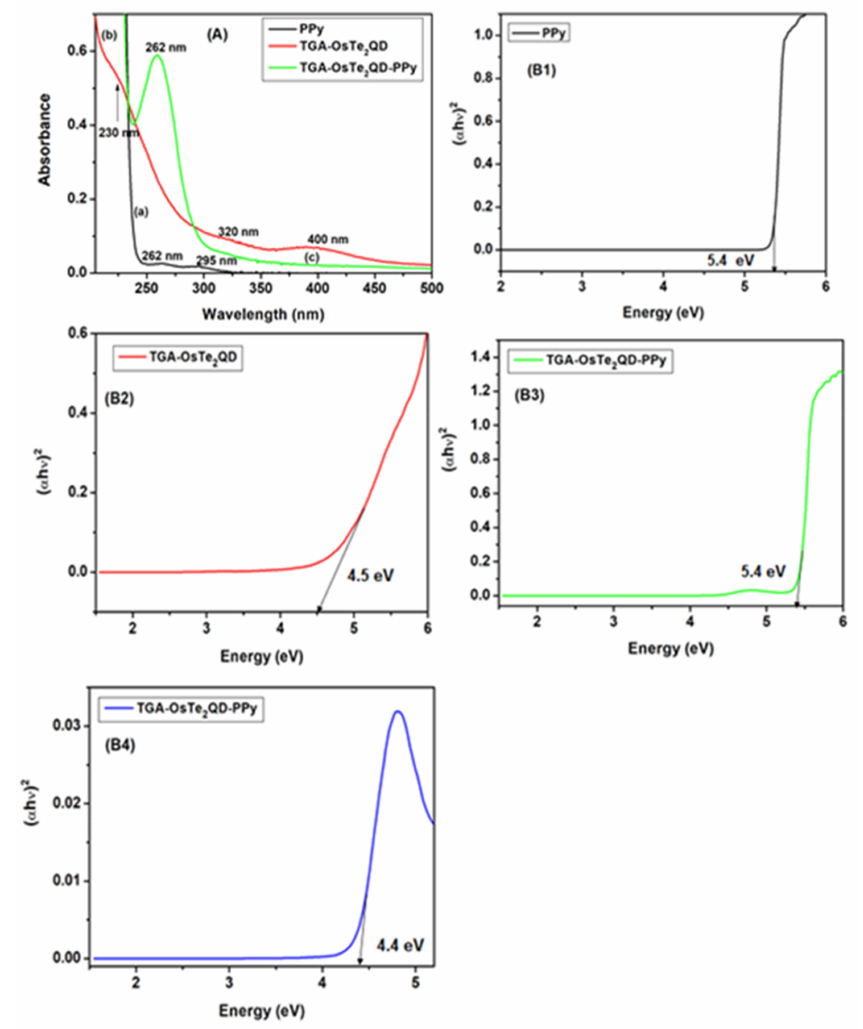
Figure 2. UV-Vis spectra and Tauc plot ( A , B1 – B4 ) of (a) PPy, (b) TGA-OsTe 2 QD and (c) TGA- OsTe 2 QD-PPy in a wavelength range of 200–500